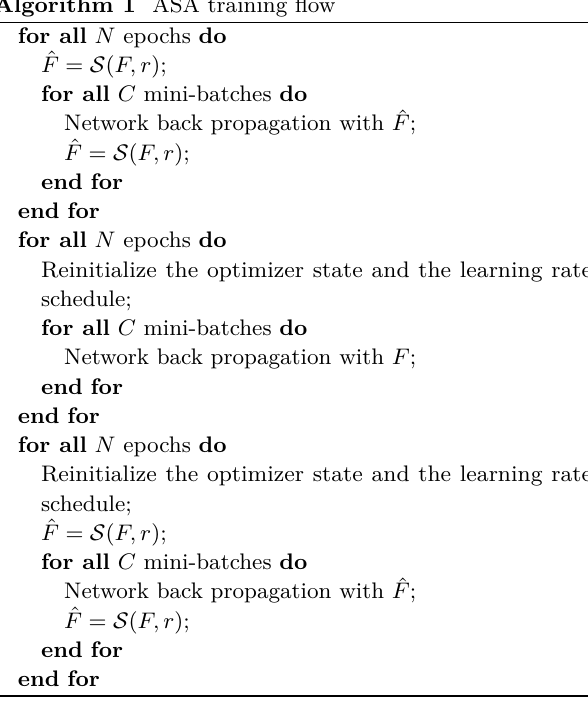
Algorithm 1 ASA training